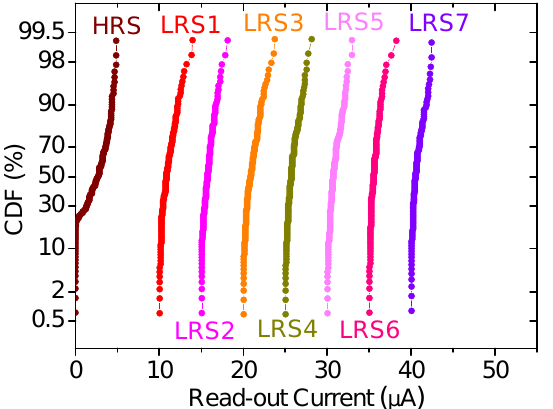
Figure 3. CDFs of the read-out currents measured for eight levels. The conductance levels were obtained by means of the Incremental Gate Voltage and Verify Algorithm (IGVVA) algorithm [36]. LRS stands for low resistance state, this means that the memristors has a low internal resistance value, and HRS stands for high resistance